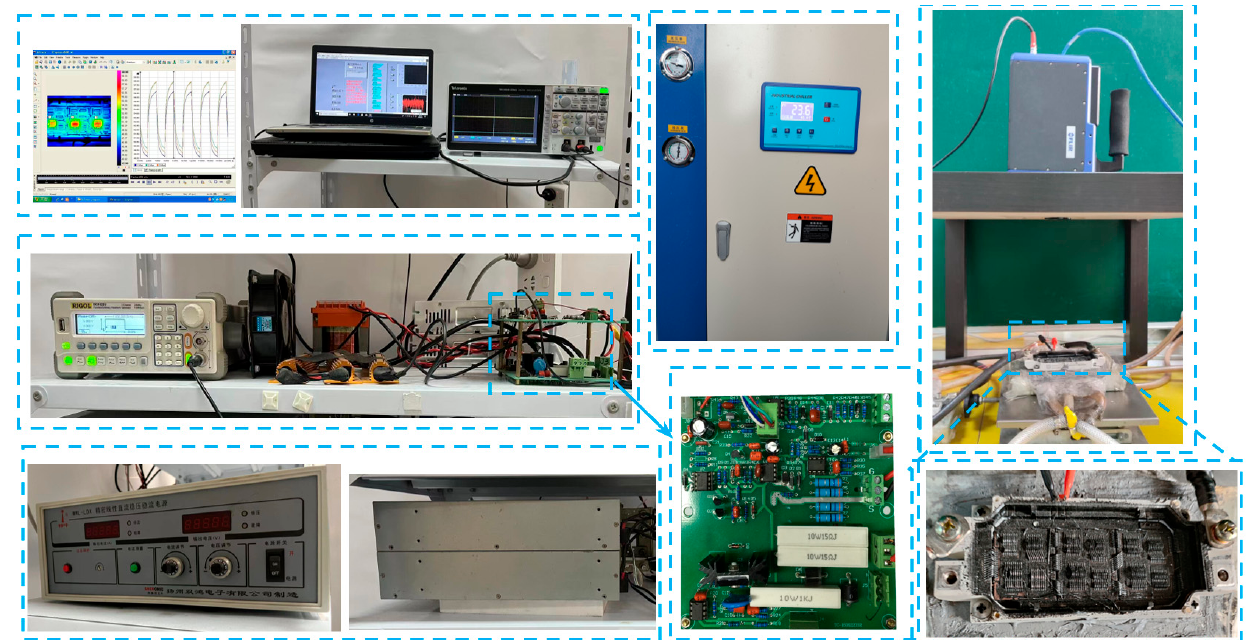
Figure 11. Power cycling test platform.